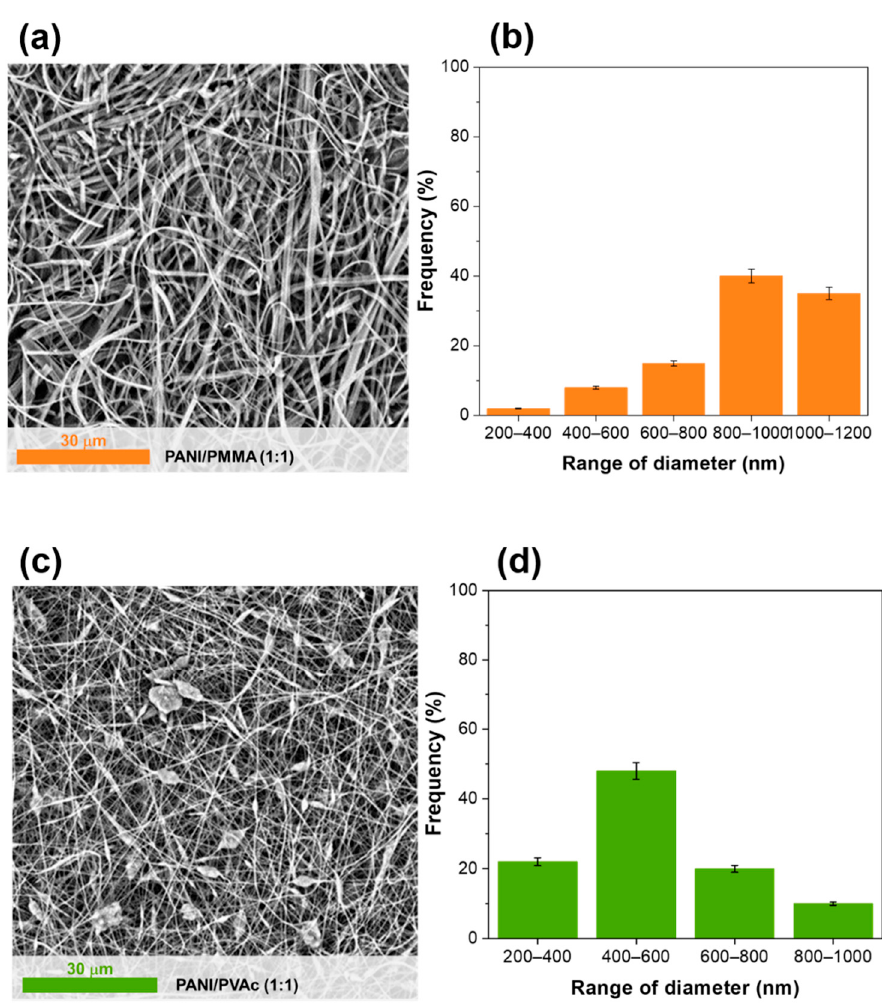
Figure 1. SEM images of ( a , b ) PANI/PMMA(1:1) nanofibers and distribution of dimensions and ( c , d ) PANI/PVAc(1:1) nanofibers and distribution of dimensions.